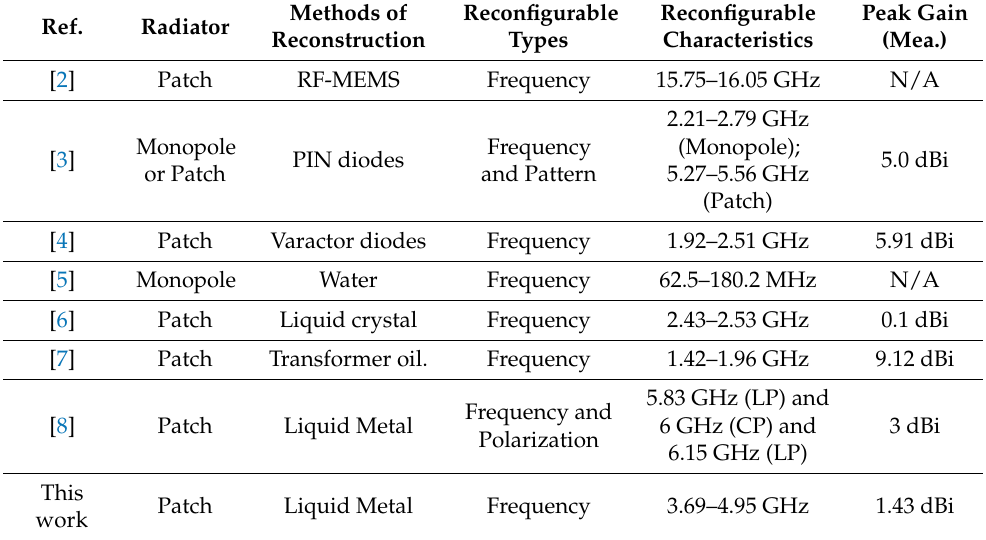
Table 3. Performance comparison for different antenna types.